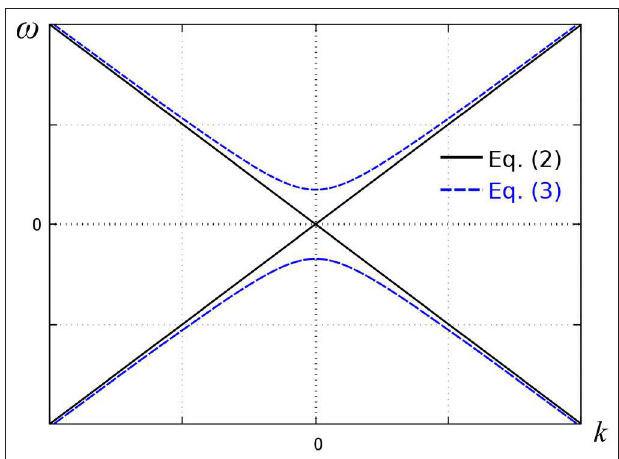
FIGURE 2 | Dispersion relation associated with Equations (2) and